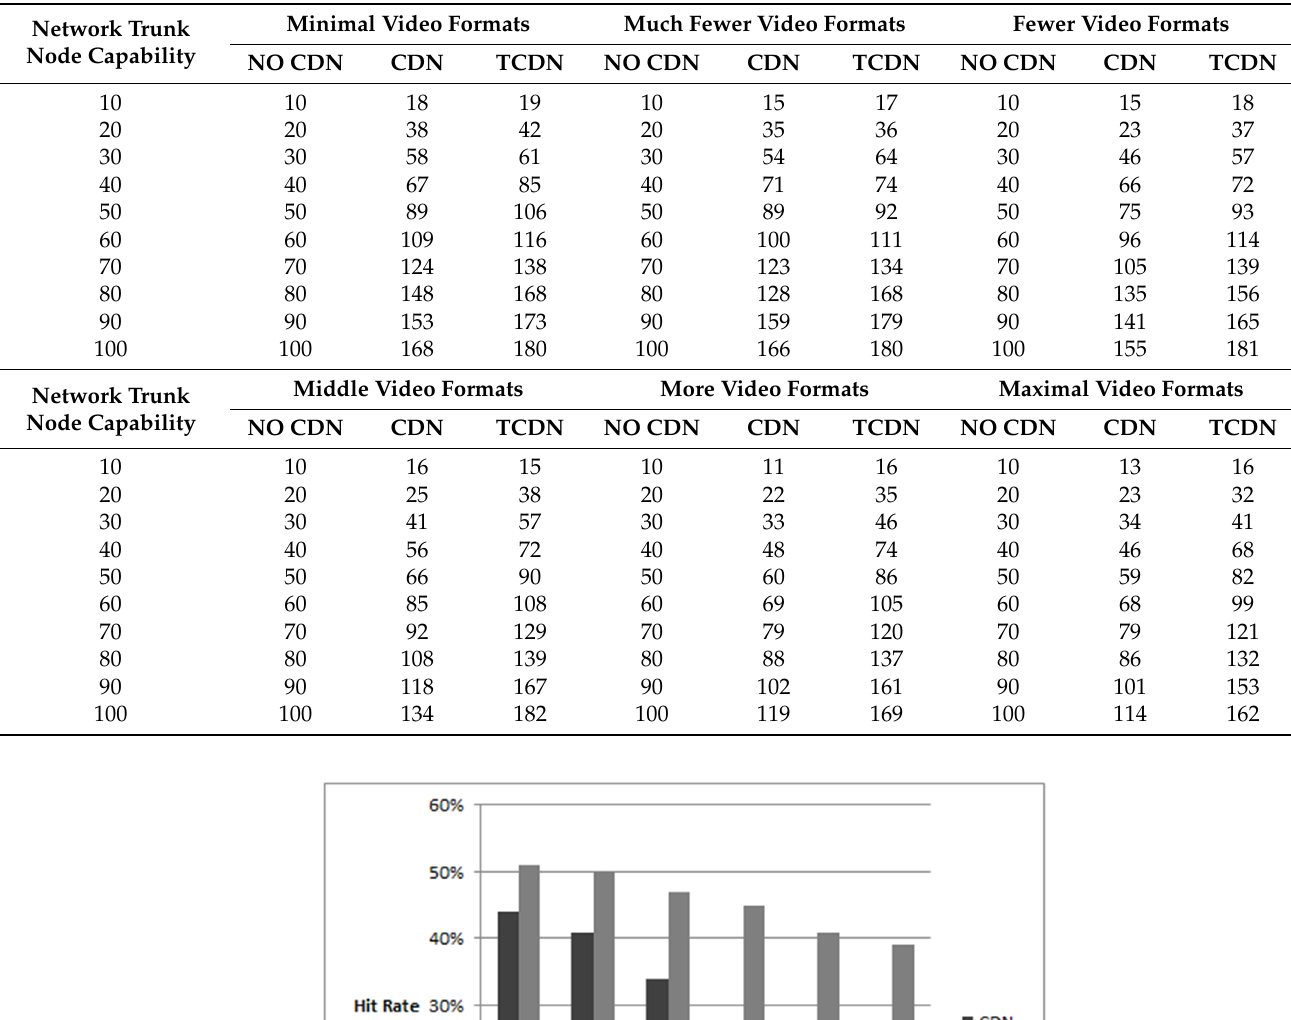
Table 6. Table of the maximum real-time user supported in different video format environments.